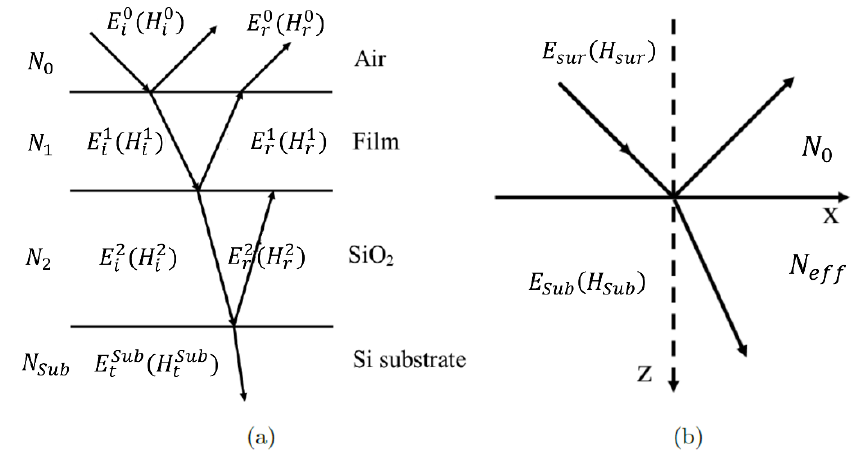
Figure 2. The schematic diagram of the transmitted and reflected waves from ( a ) triple layer ( b ) single interface structures. The reflectivity at each interface is described using Fresnel equation and depends on the optical constants of the materials at each interface. The reflectivity of the triple layer structure is determined by the interference between the reflected waves from all interfaces and the transmitted waves through all layers.